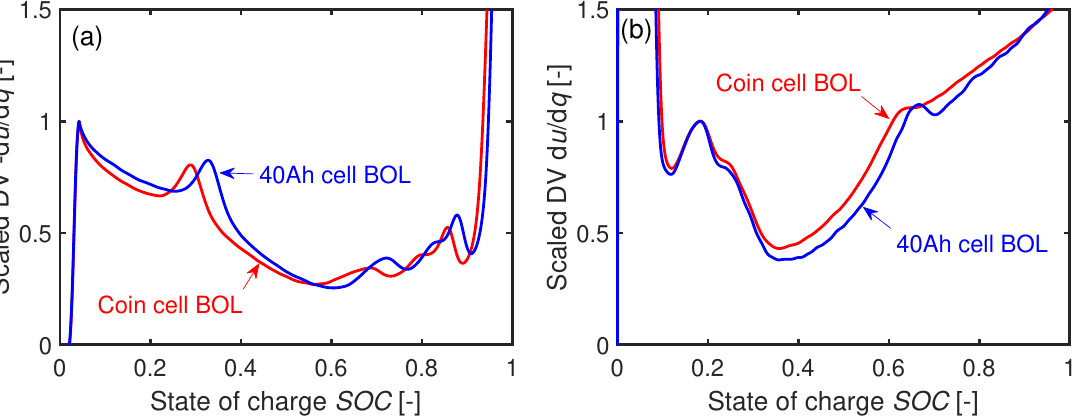
Figure 6. Comparison of the DVs from a 40 Ah cell and a coin cell at BOL for ( a ) discharge with C/3 at T = 35 ◦ C and ( b ) charge with C/3 at T = 25 ◦